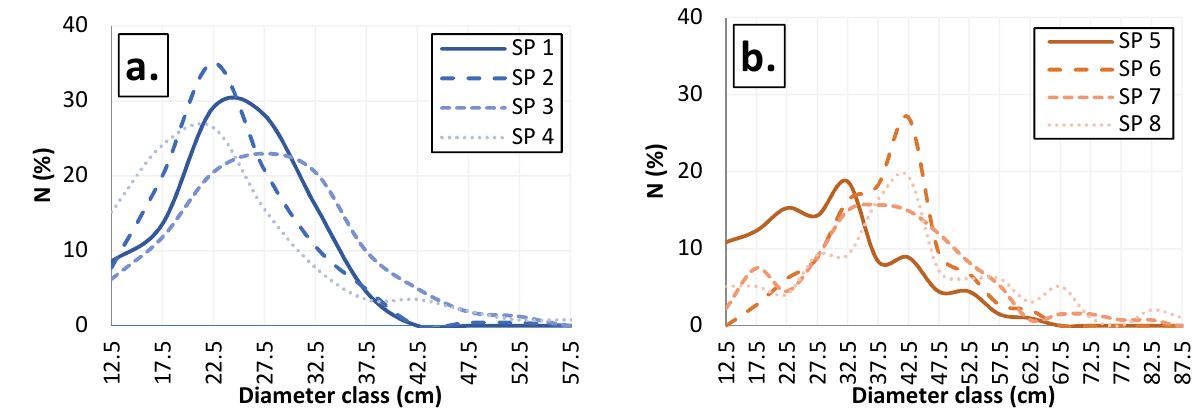
517 522 527 532 537 542 547 552 557 5 . . . . . . . . . 12 . Figure 4. Distribution of trees by diameter classes in the stands of Serbian spruce ( a ) and Macedonian pine ( b ). In the stands of Macedonian pine, dbhA grows with an increase in mixing from 29.6 cm (SP 5) to 41.2 cm (SP 8). Like in the case of Serbian spruce, the sample plots with